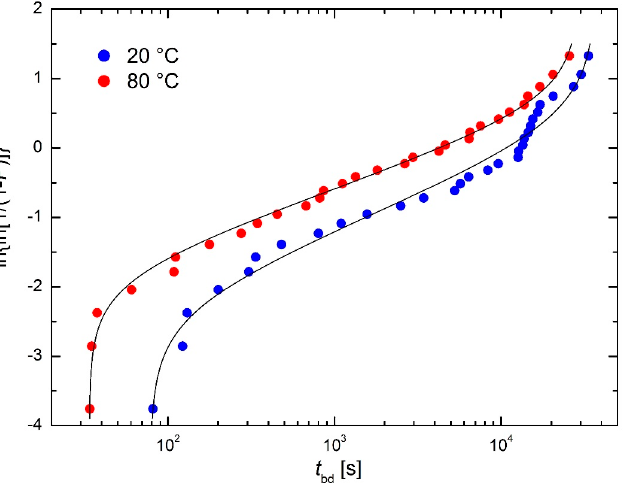
Figure 1. Weibull plots of the time-to-breakdown of Hf-doped Ta 2 O 5 /SiO 2 capacitors under stress voltage − 4.5 V at the presented temperatures [8].